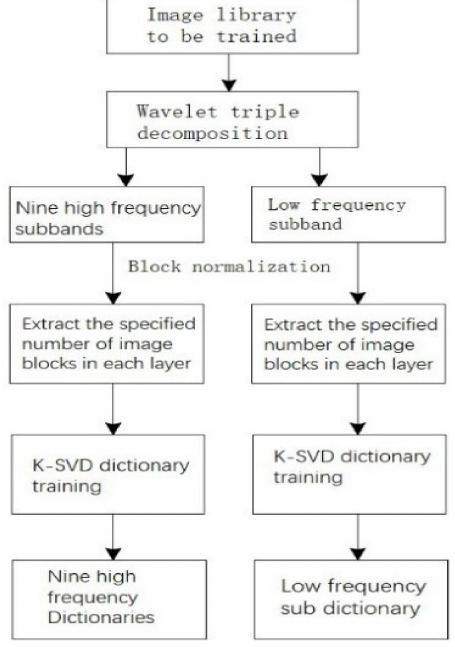
Figure 1. K-SVD Schematic diagram of multiscale dictionary training.